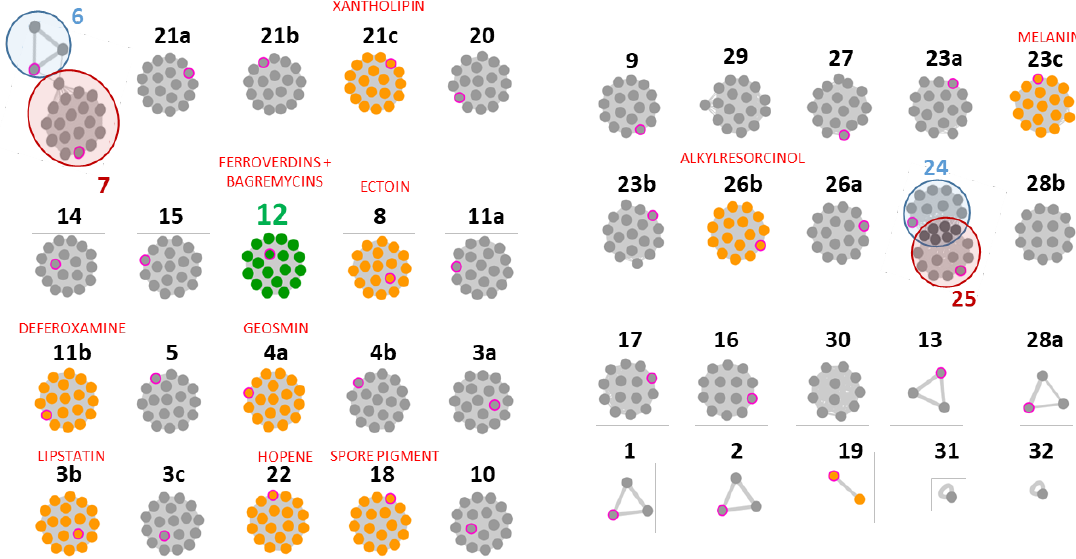
Figure 2. Strain distribution of the 42 biosynthetic gene clusters (BGCs) identified in the genomes of 18 S . lunaelactis strains. Each node corresponds to a BGC in one strain, and groups of nodes (“grapes”) indicate that the BGC is conserved in different S . lunaelactis strains. The nodes are linked by a grey line whose width is proportional to the orthology level between the connected BGCs. Color code: pink circles indicate nodes of the type strains MM109 T ; green nodes for the bag / fev BGC; orange nodes refer to known metabolites/BGCs; grey nodes refer to cryptic metabolites/BGCs.